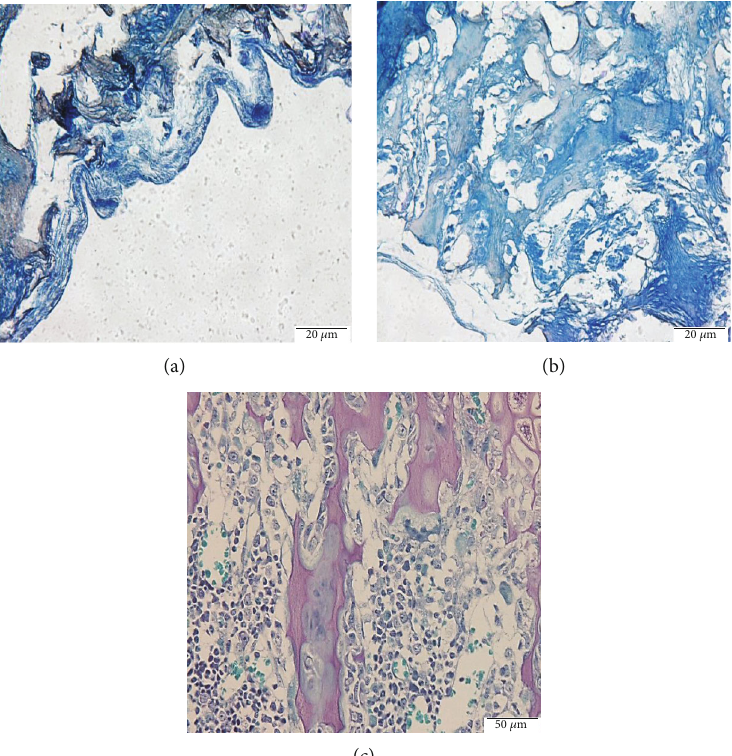
Figure 8: Cartilage-like tissue stained by Alcian Blue: magni fi cation 20x (a), 40x (b), and chondrocytes embedded in cartilage matrix Alcian Blue at day 21 (magni fi cation 50x) (c).